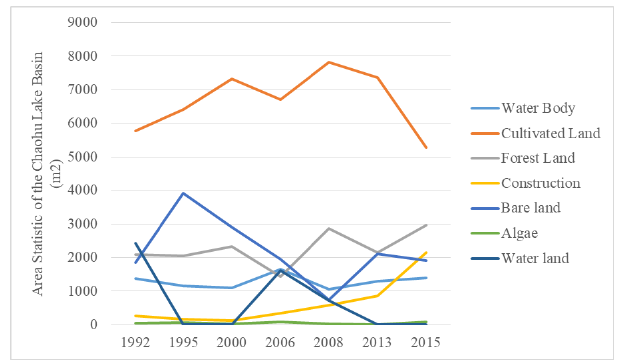
Figure 3. Area variation statistics data (from 1992 to